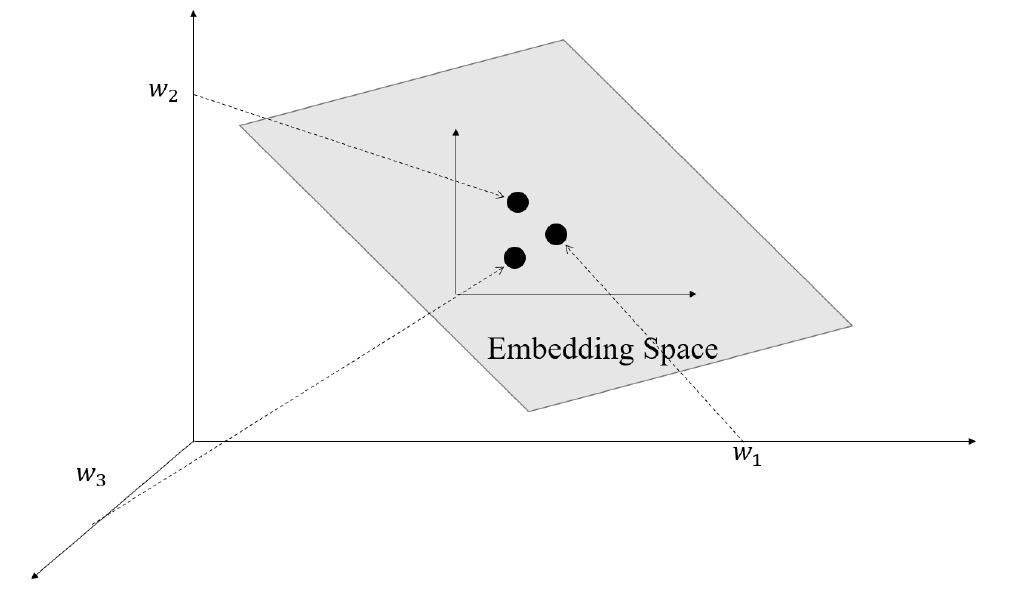
Figure 6. The embedding space of